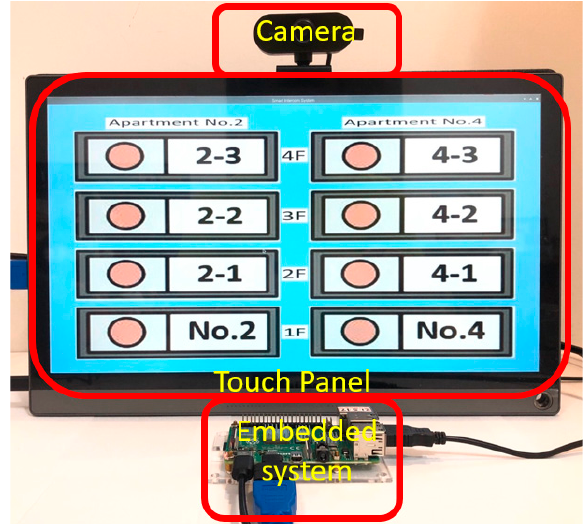
Figure 8. The prototype of this system hardware.